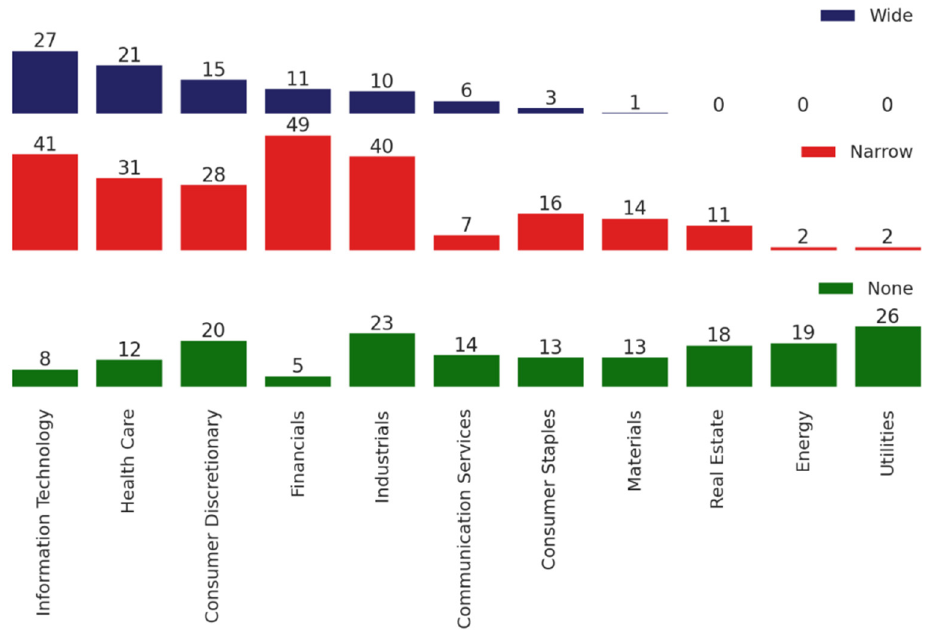
Figure 3. Moat per